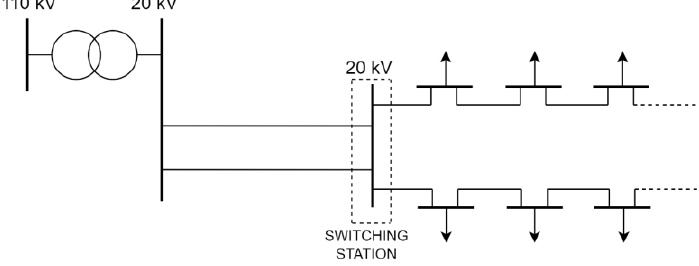
Figure 13. Using a switching station as a support point in distribution networks.